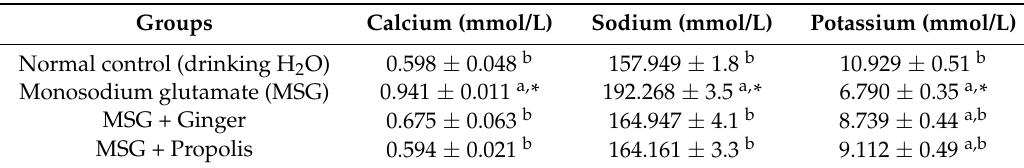
Table 2. Effect of ginger and propolis on calcium, sodium and potassium levels of brain tissues in MSG-treated rats.